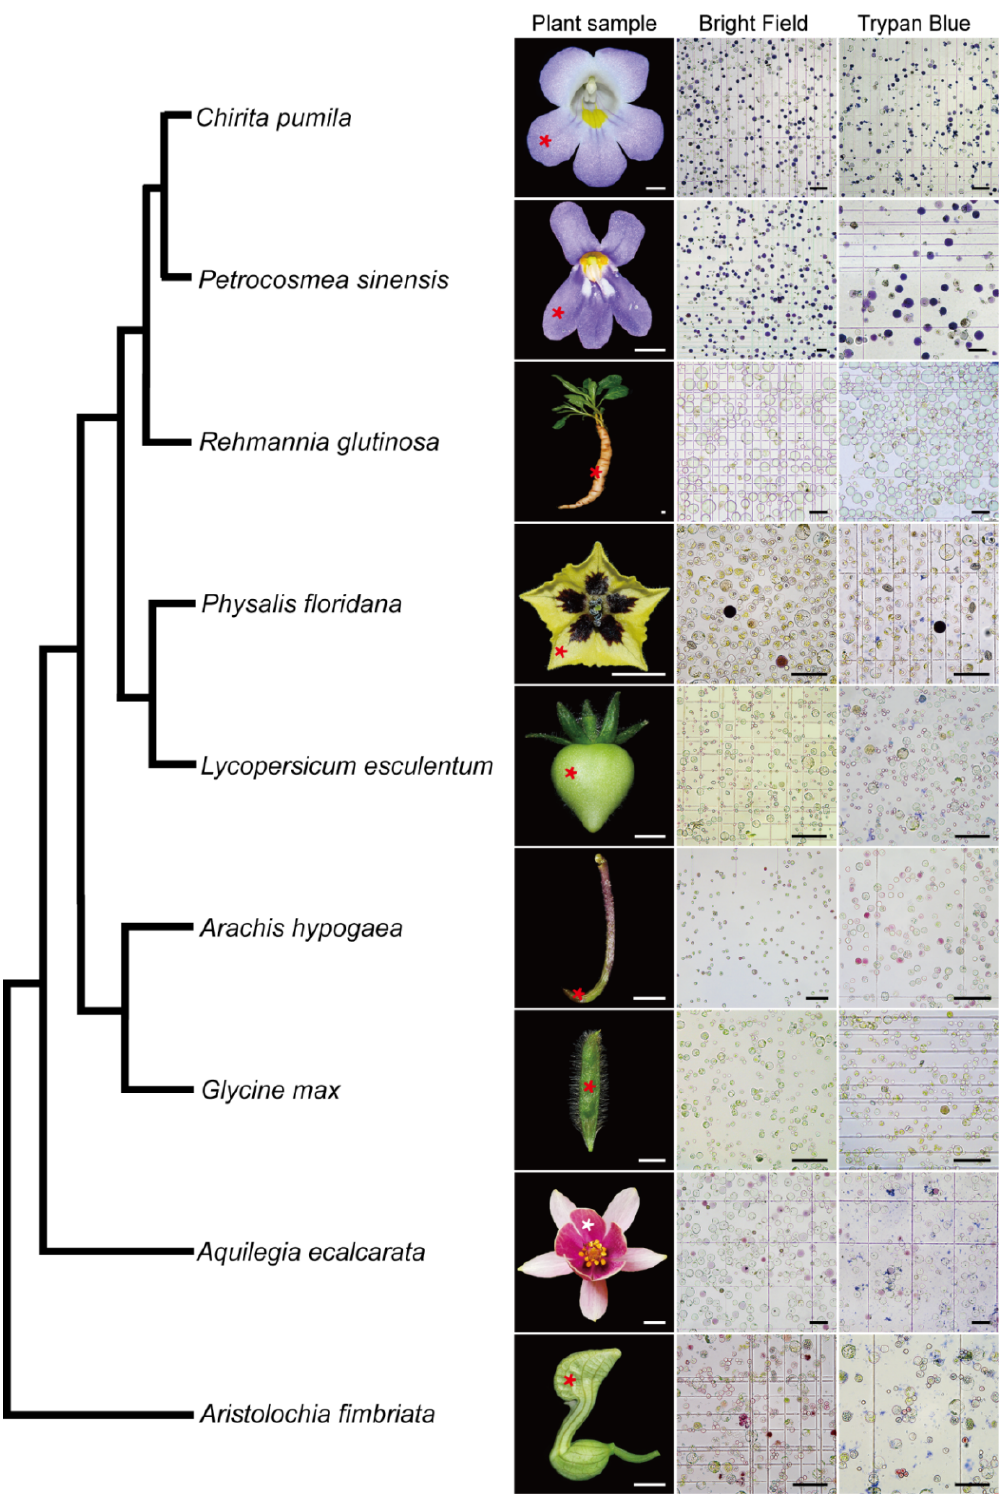
Figure 6. Validation of the protoplast isolation protocol from representatives of the angiosperm. Please note that some of cells are in dark purple or magenta color due to anthocyanin biosynthesis in the samples. The phylogenetic relationship of the representative species was based on Angiosperm Phylogeny Group (APG) IV. Asterisks in the plant sample row indicate the tissues used for the protoplast extraction. Scale bars, plant samples, 0.5 cm; protoplast images, 100 μ m.